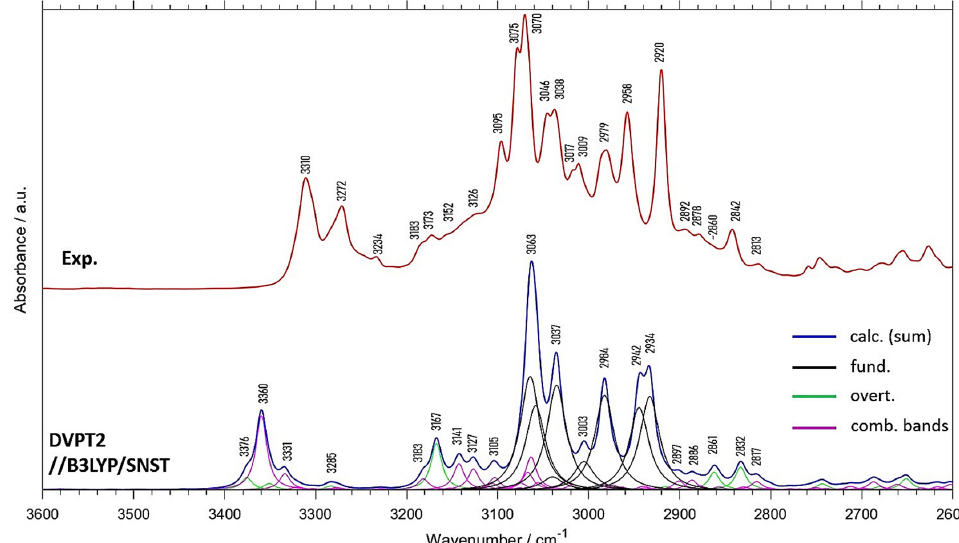
Figure 2. Spectrum of crystalline menadione in the 3600–2600 cm − 1 range together with the anharmonic vibrational spectra (DVPT2//B3LYP/SNST). The detailed band assignments are presented in Table 2. Table 2. Experimental and calculated band positions [cm − 1 ] together with calculated relative intensities [%] and assign- ments of the fundamental bands in the 3600–2600 cm − 1 range for crystalline menadione. Highlighted (bold) are the fundamental bands. Experimental Experimental Exp. Intensity Calc. Intensity Position Difference Calc. Position Assignment (a) Position (Normalized) (Normalized) (Exp—Calc) - 3376 11.0 2( δ ring, ν